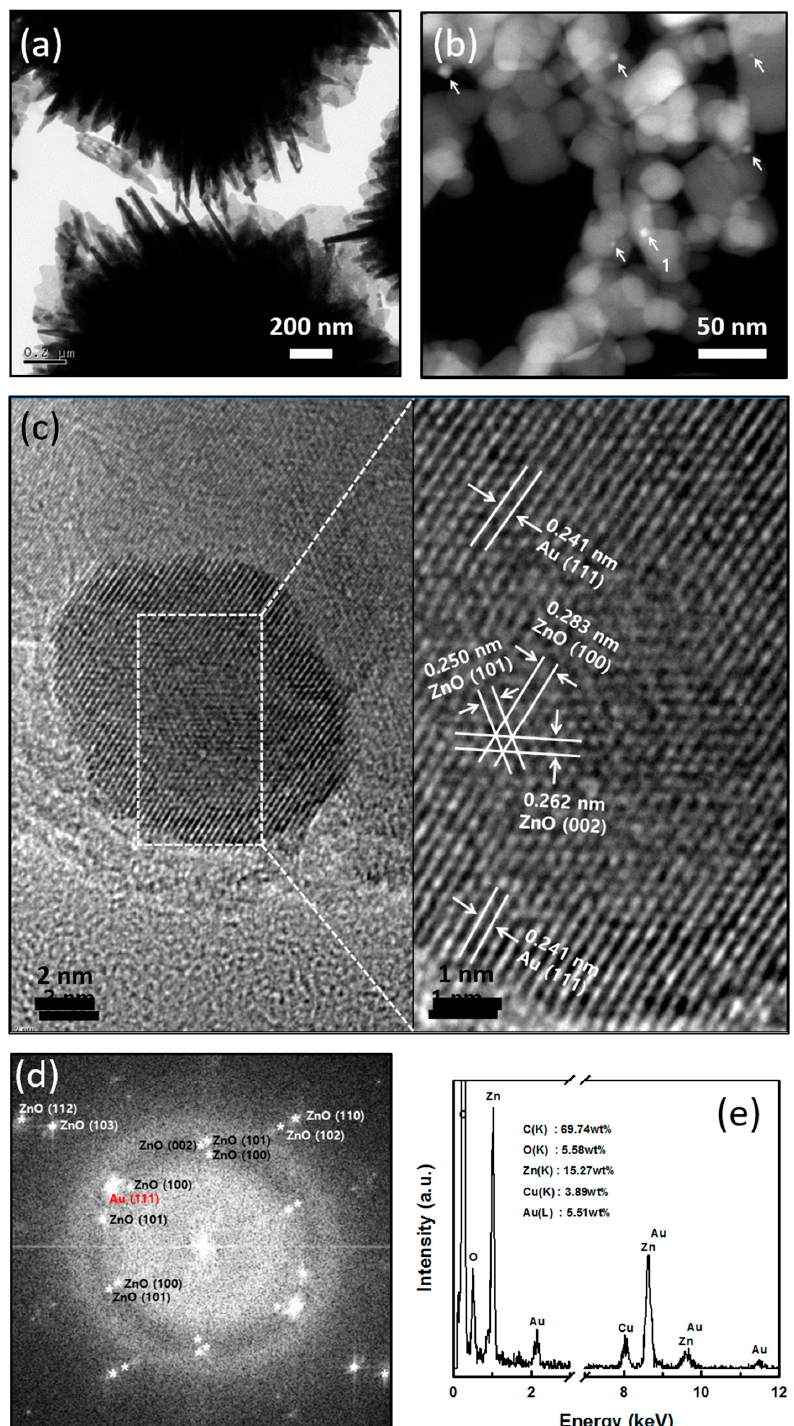
Figure 4. ( a ) TEM image of pristine cotton ball-like Au/ZnO; ( b ) HAADF-STEM image of crushed cotton ball-like Au/ZnO; ( c ) HRTEM image (The inset shows the HRTEM image of the marked area by the square 1) of a single particle as indicated by arrow 1 in Figure 4b; ( d ) Fourier transform image; and ( e ) the EDS spectrum for the dotted square in Figure 4c,